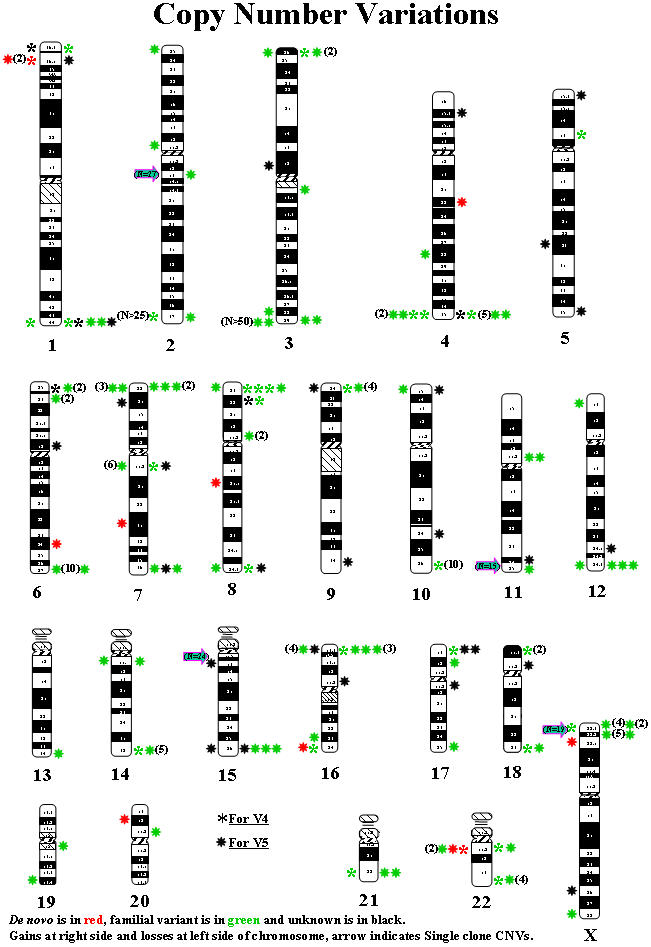
Ideogram of Copy Number Variations (CNVs). Big arrows indicate CNVs Type 1 (N = 119), except AZFc on the Y chromosome (N = 35). * represents V4 and for V5 for CNVs Type 2 (N = 143). A total of 262 copy number variations (CNVs) were identified by CMA. Of these, 217 were interpreted as familial variants (green) and 11 were determined to be de novo (red); 34 CNVs that await parental studies are depicted with unknown clinical significance (black). Positions showing losses are on the left side of the chromosome whereas gains are on the right side.